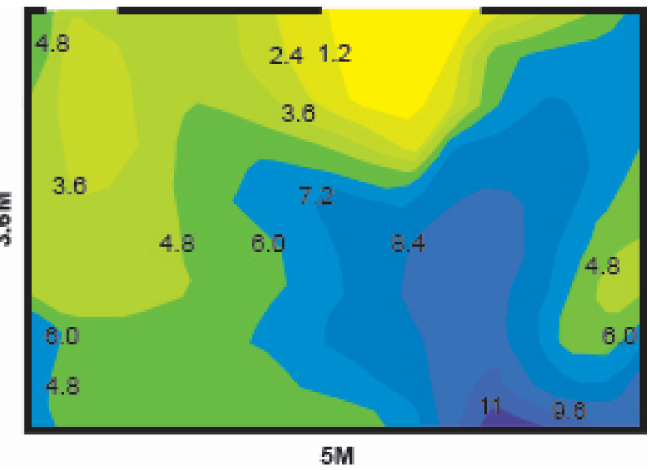
Figure 4. ACH = 0.5 time, average concentration: 5.56 pci (Max: 11.84 pci, Min: 0.44 pci).